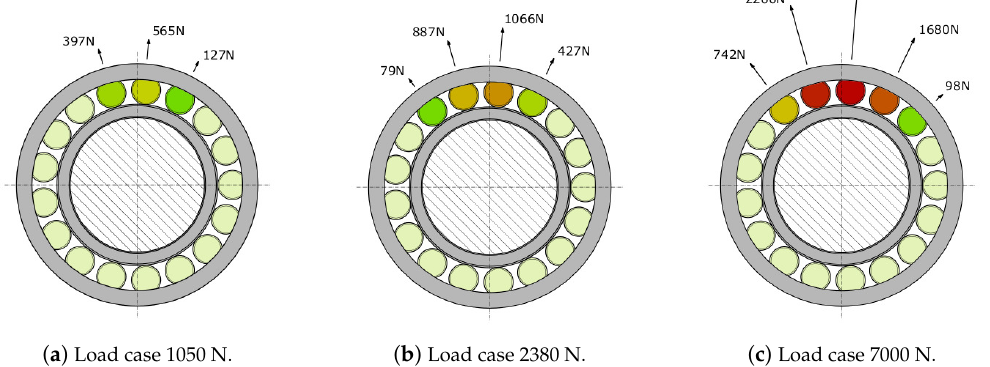
Figure 3. Load distribution of the CRB for three static load cases. The transmitted radial load is directed vertically upwards.